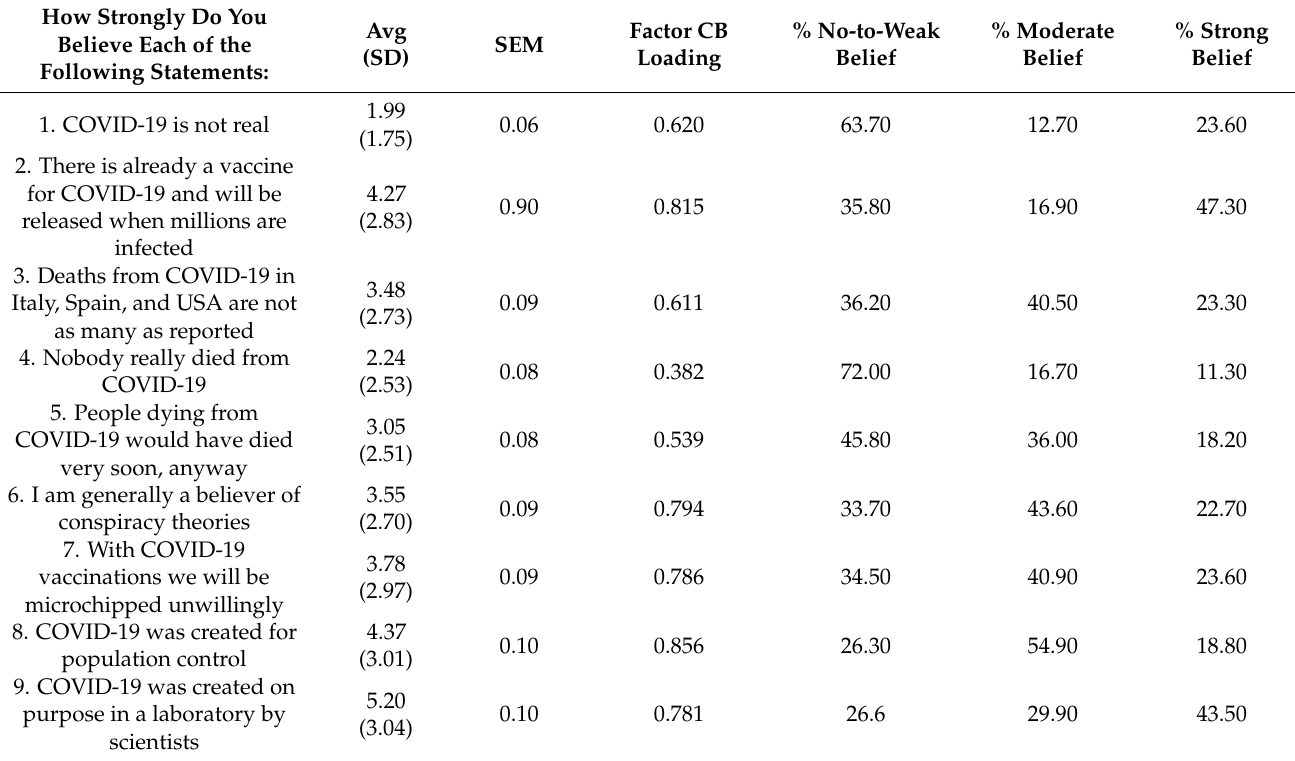
Table 1. Average responses, factor loadings, and percentage of weak, moderate, and strong belief endorsements for each conspiracy theory